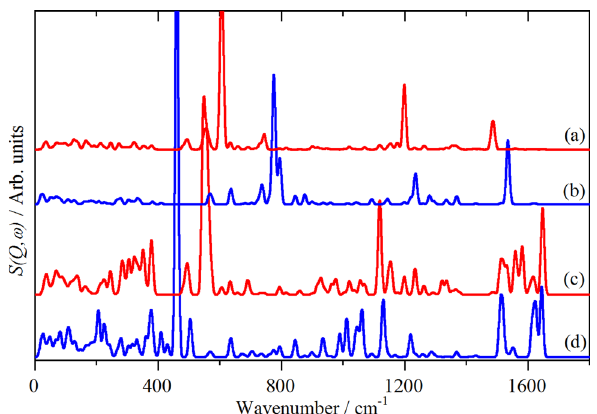
Figure 8. Pseudo-spectra of: ( a ) the peptide amide hydrogen in the dl–ld racemate and ( b ) in the dd–ll racemate, ( c ) the hydrogens in the –NH 3+ moiety in the dl–ld racemate and ( d ) in the dd–ll